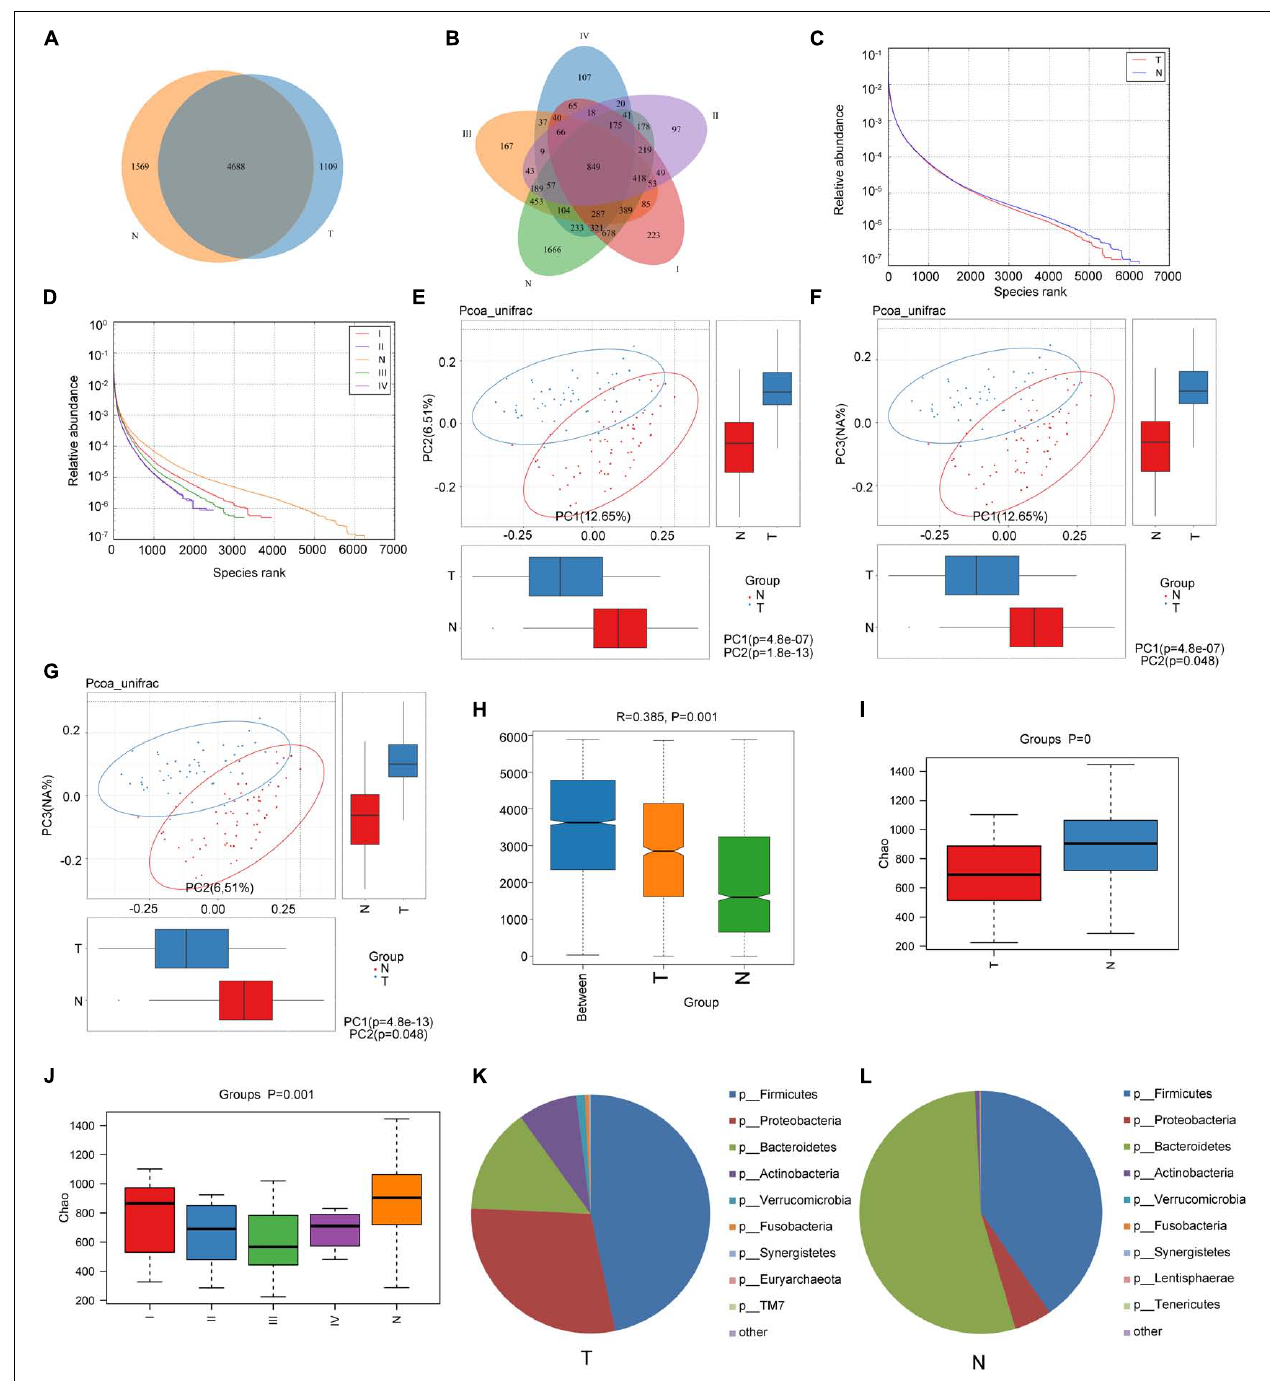
FIGURE 1 | Comparison of the composition of intestinal flora between healthy subjects and CRC patients. (A,B) Venn diagrams according to the different grouping methods; (C,D) rank abundance curve according to the different grouping methods; (E–G) principal Co-ordinates Analysis (PCoA) with unweighted Unifrac distance; (H) use of ANOSIM to analyze differences between the groups and within the groups; (I,J) Chao1 index analysis according to the different grouping methods; and (K,L) analysis of the composition of the intestinal flora of cancer patients and healthy subjects at the phylum level.